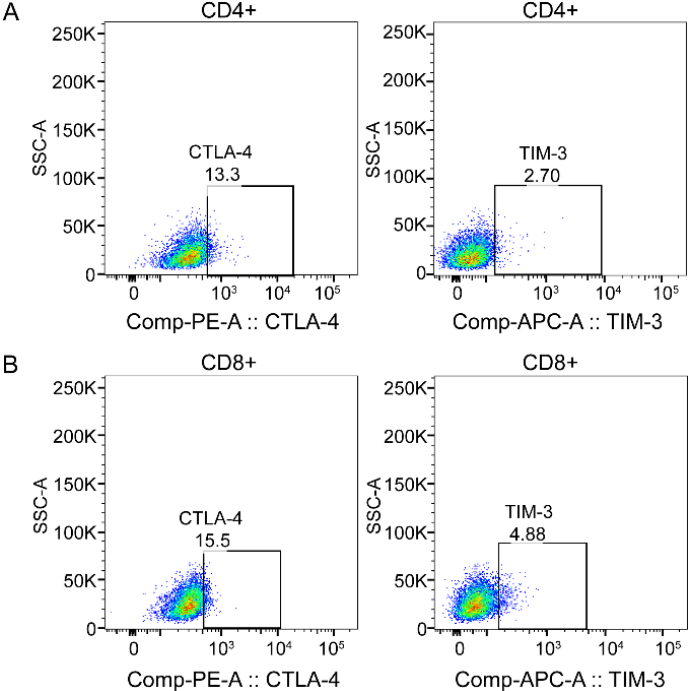
Figure 2. Example functional marker gating strategy for CD4+T and CD8+T lymphocytes. ( A ) Distribution of CTLA-4 and TIM-3 on CD8+T cells; ( B ) distribution of CTLA-4 and TIM-3 on CD4+T cells. Figure generated using Flow Jo.